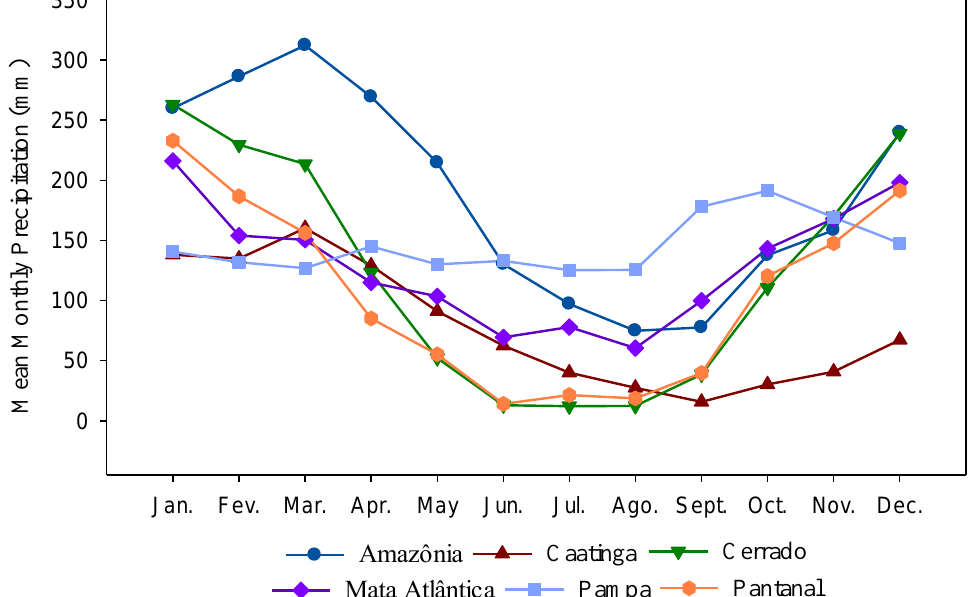
Figure 8. Distribution of monthly mean precipitation (2002 to 2010) in the Brazilian biomes (TRMM